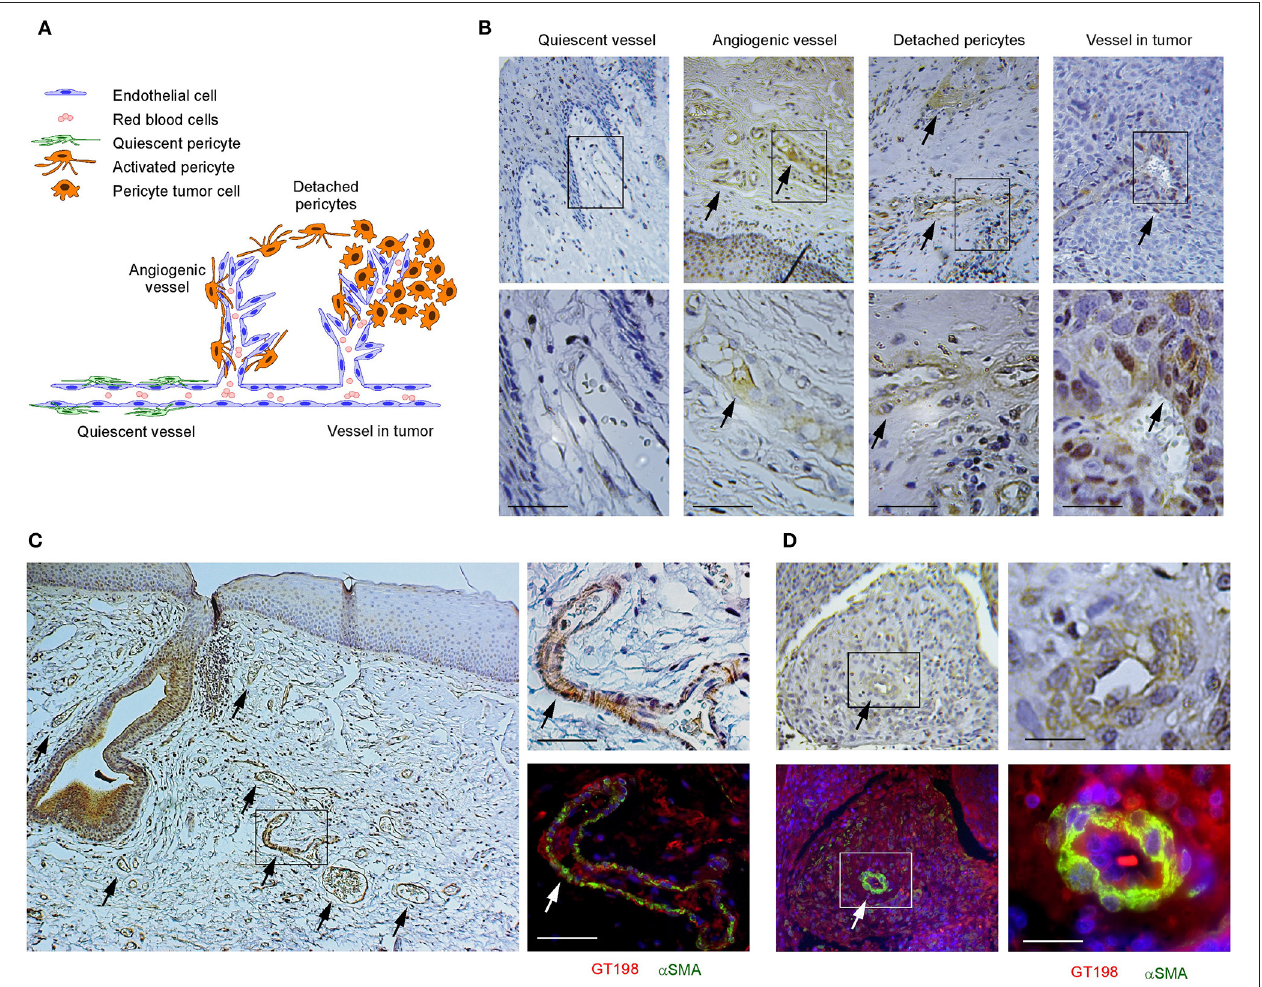
FIGURE 1 | GT198 + angiogenic blood vessels in human oral cancers. (A) A hypothetic model comparing pericytes in quiescent vessel in green and in angiogenic and tumor enclosed vessels in orange. (B) Immunohistochemical staining of GT198 in human oral cancer. Pericytes in quiescent vessel are GT198 − . Angiogenic pericytes, detached pericytes, and pericytes in a tumor are GT198 + . The tumor enclosed vessel is functional with red blood cells inside. Boxed areas are enlarged below. (C) In an epithelial oral cancer, multiple GT198 + angiogenic vessels are present around the GT198 + epithelia in tumor development. An adjacent section is immunofluorescent double-stained with GT198 in red and α SMA in green and counterstained with DAPI in blue. (D) An oral tumor enclosing a vessel from the same patient is double-stained with GT198 and α SMA showing a vessel at tumor center. Boxed areas are enlarged at the right. Extended view is shown in Supplementary Figure 1 . Arrows indicate GT198 + pericytes. Immunohistochemistry sections are counterstained with hematoxylin. Scale bars = 100 µ